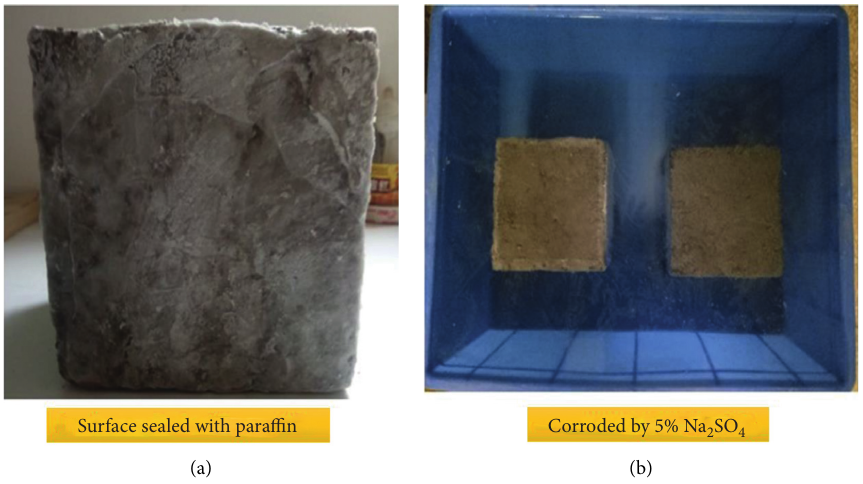
Figure 3: Paraffin cover and salt corrosion process of concrete specimens.